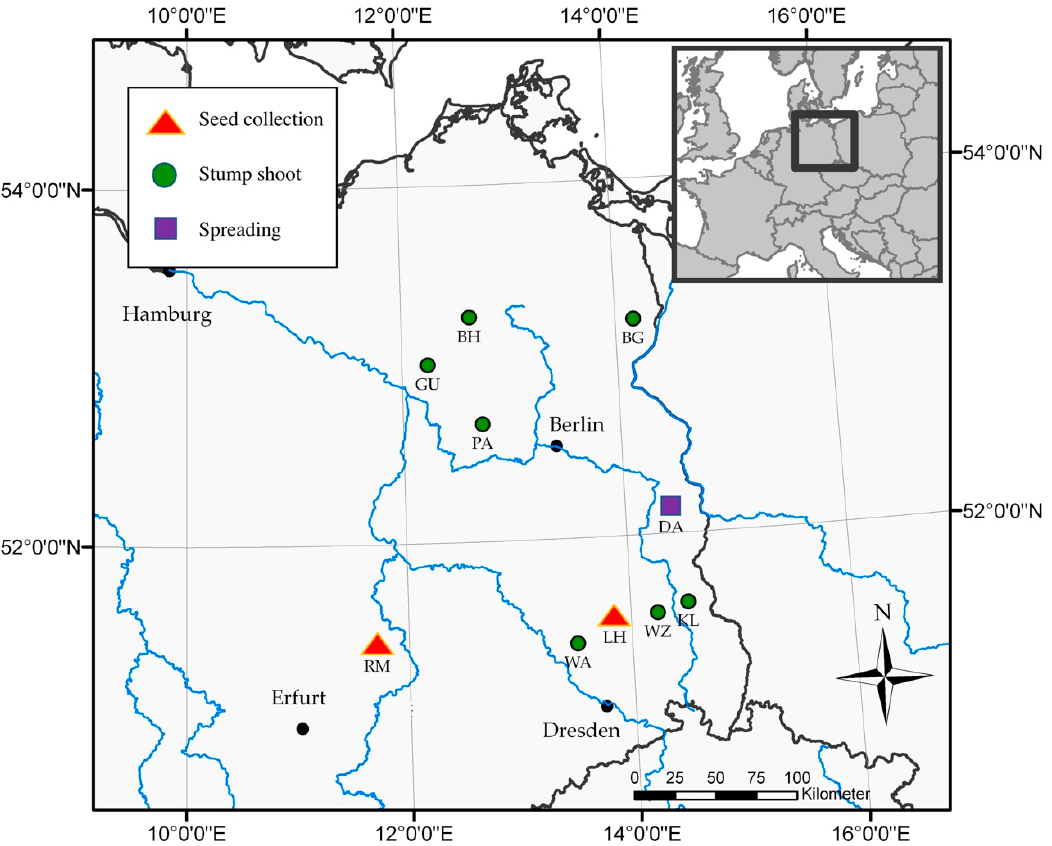
Figure 1. Map of the study area in Europe, indicating the ten R. pseudoacacia sampling sites in Germany [81]. Red triangles are sites visited for seed collection, green dots are the sites where sample plots for the stump shoot analysis were measured, and the purple square is the study site of the UAS image analysis, which was applied for the spreading detection. For an overview of site abbreviations, see Table 1.